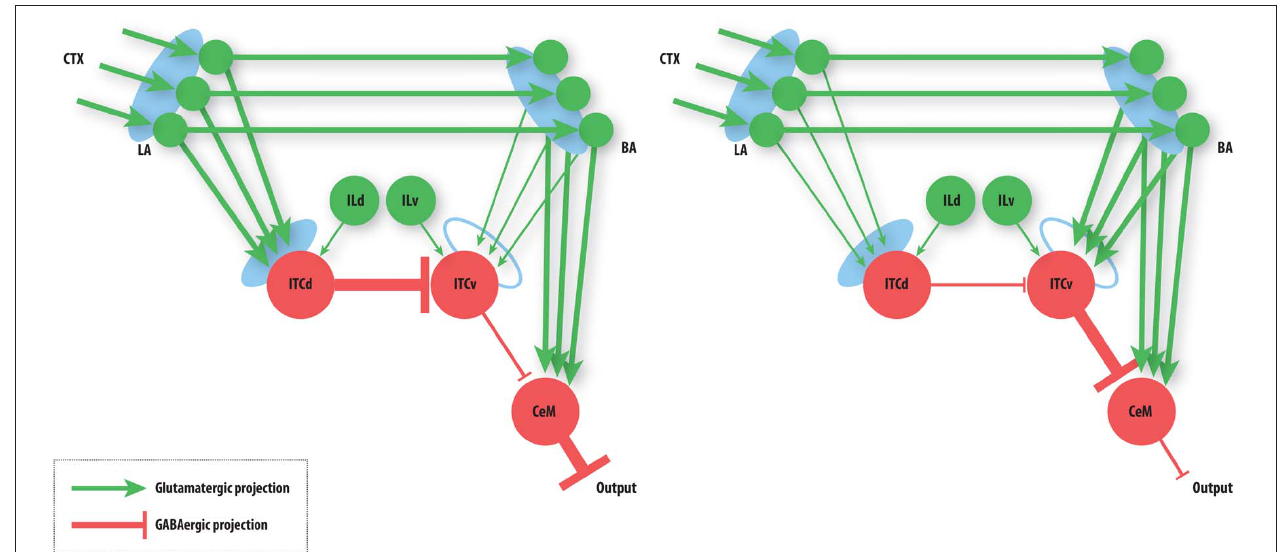
FIGURE 4 | Summary of basic model behavior. Line thickness denotes strength of activity. Left: The state of the network after fear acquisition. ITCd inhibits the ITCv, thereby disinhibiting CeM, allowing BA to excite it. CeM excitation leads to fear responding. Right: The state of the network after